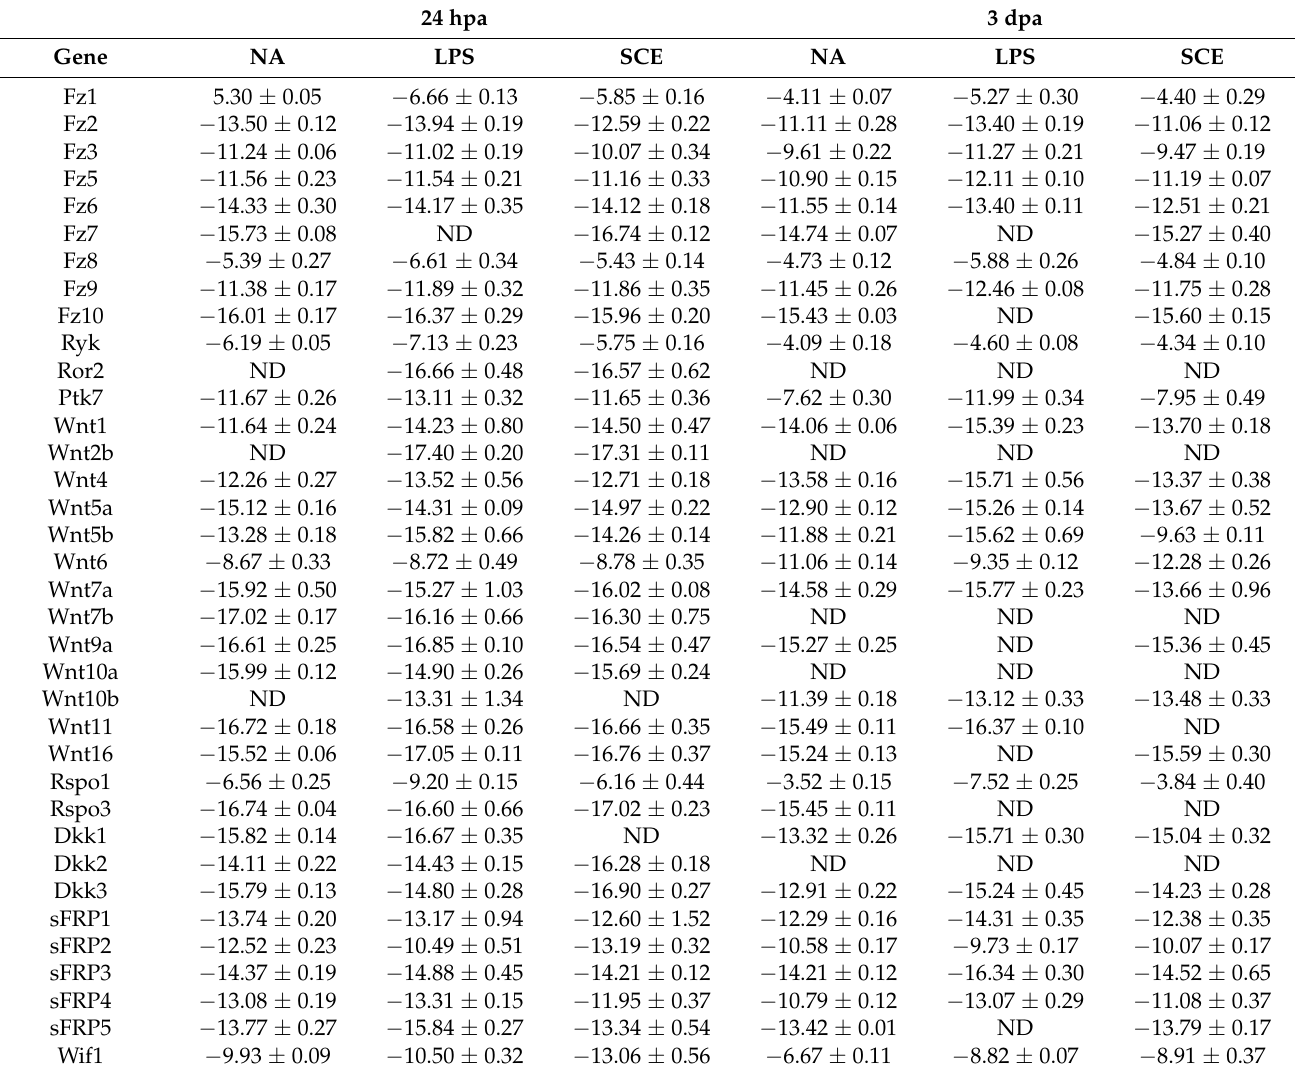
Table 2. ∆ Cts values ± SEM of all detected genes at the different times post-activation that were evaluated and for the three experimental situations that were analyzed. hpa: hours post-activation; dpa: days post-activation; NA: non-activated; ND: non detected; LPS: lipopolysaccharide; SCE: spinal cord